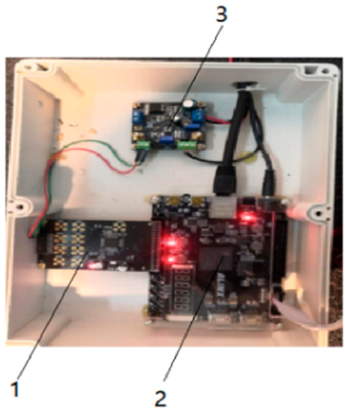
Figure 1. High-speed photographic collection of grain collision information. 1—High-speed camera display, 2—support tripod, 3—sensor mounting bracket, 4—grain loss sensor, 5—high-speed cam- era, 6—signal acquisition program, 7—height-fixing frame, 8—grain falling height position, 9—fill- in light.